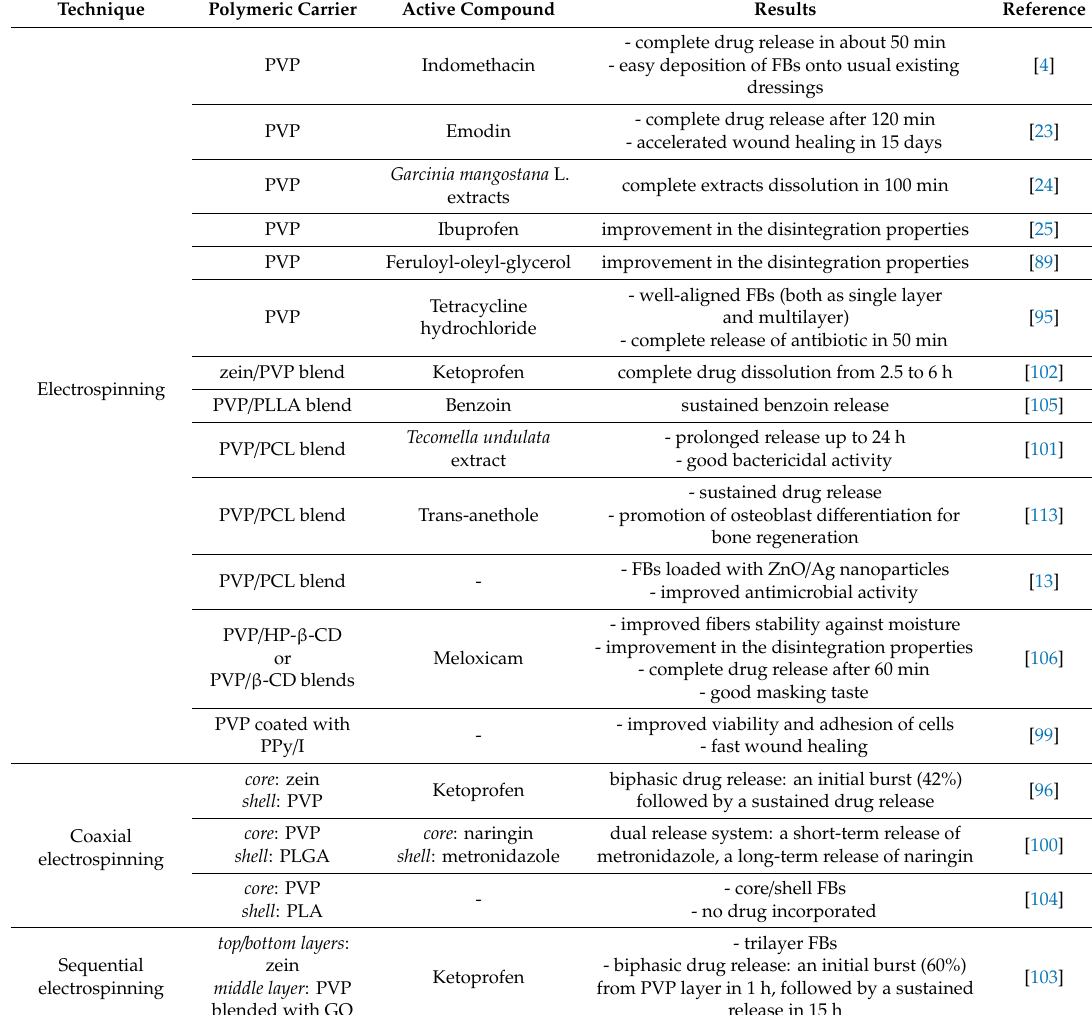
Table 2. PVP-based fibers. FBs, fibers; PLLA, poly( l -lactic acid); PCL, polycaprolactone; H- β -CD, hydroxypropyl- β -cyclodextrin; β -CD, β -cyclodextrin; PLGA,polylactic-co-glycolicacid; PLA,polylactic acid; GO, graphene oxide; PPy / I, polypyrrole /